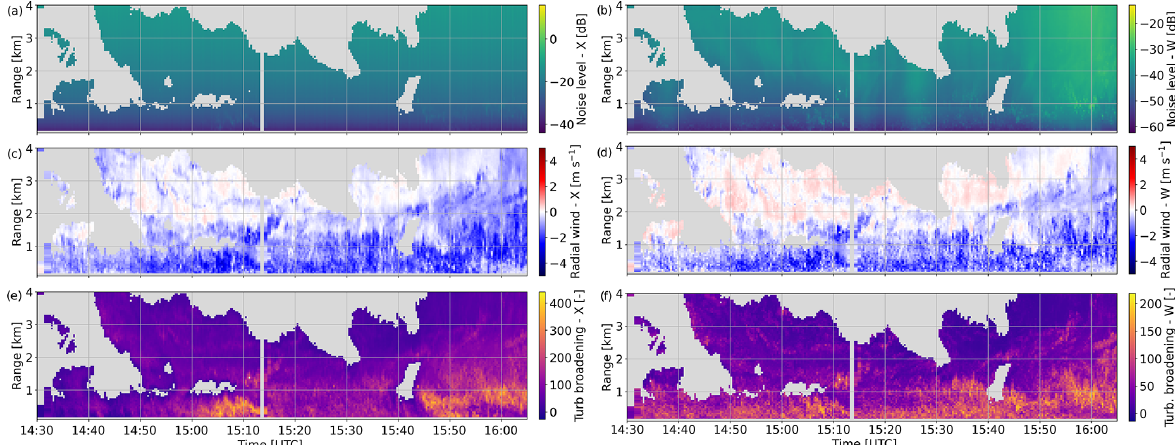
Figure 6. Time–height plot of additional retrieved variables: (a) (respectively b ) noise level at the X (respectively W) band; (c) (respectively d ) radial wind at the X (respectively W) band; (e) (respectively f ) broadening at the X (respectively W) band.